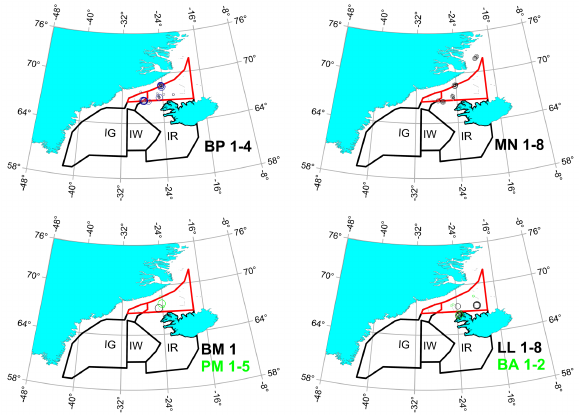
Figure 3. Sightings of cetaceans in the fall capelin survey. Symbol size is proportional to group size range indicated on the panels. Overlap between the summer and fall surveys is outlined in red. BP – fin whale; MN – humpback whale; BM – blue whale; PM – sperm whale; LL – white- beaked dolphin; BA – common minke